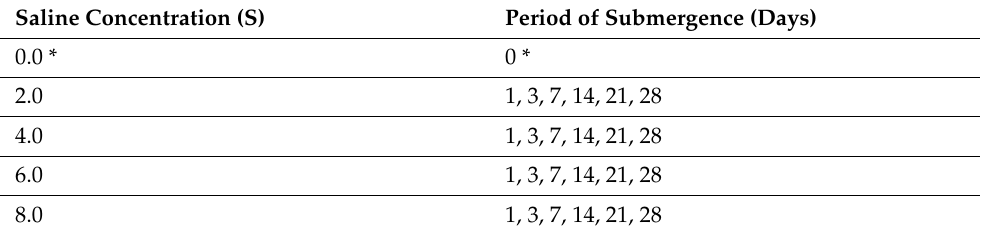
Figure 2. Sand samples submerged in saltwater of different concentrations. Table 2. Test Matrix.